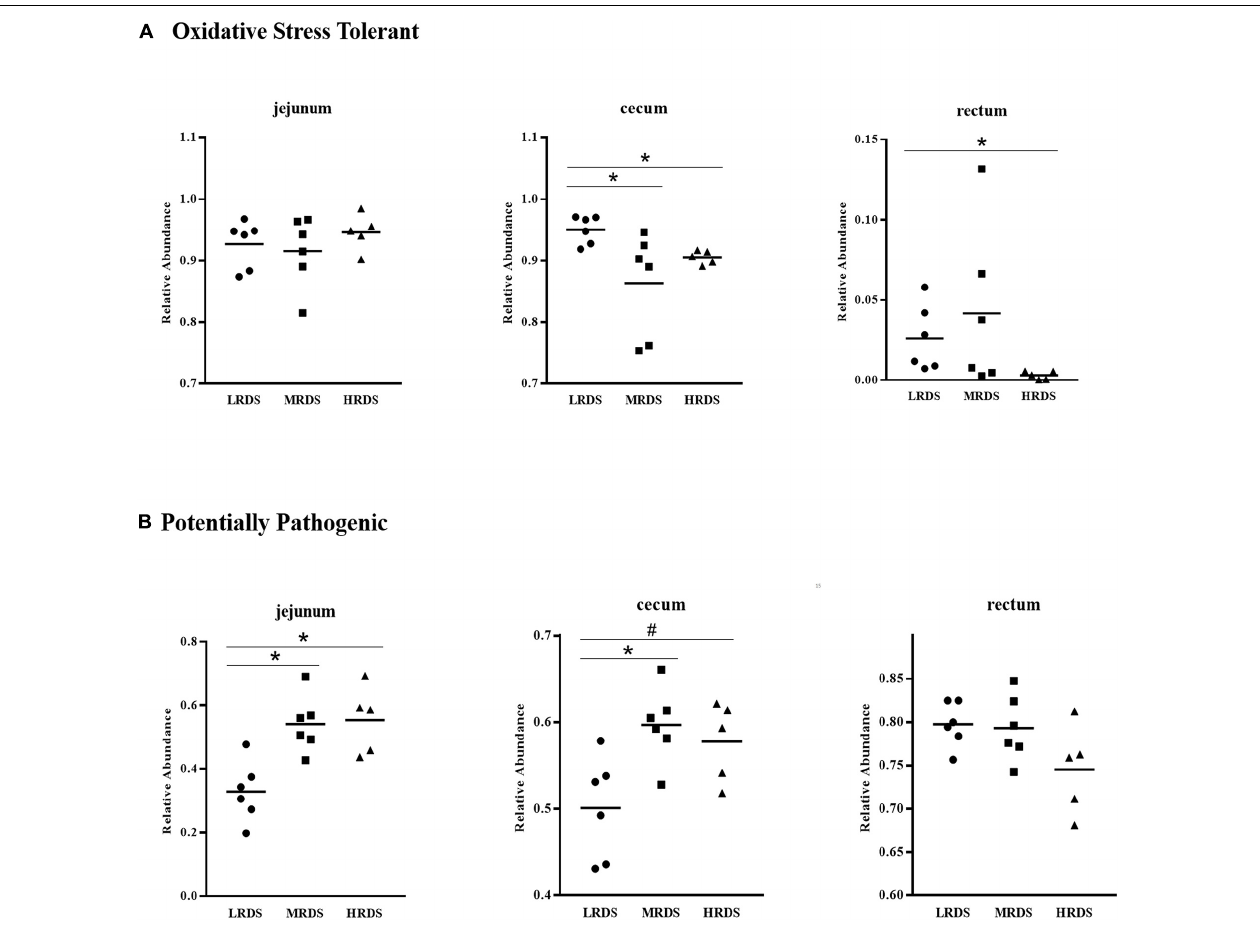
FIGURE 3 | BugBase phenotypes prediction. (A) The oxidative stress tolerant. (B) The potentially pathogenic * P < 0.05, # 0.05 < P <